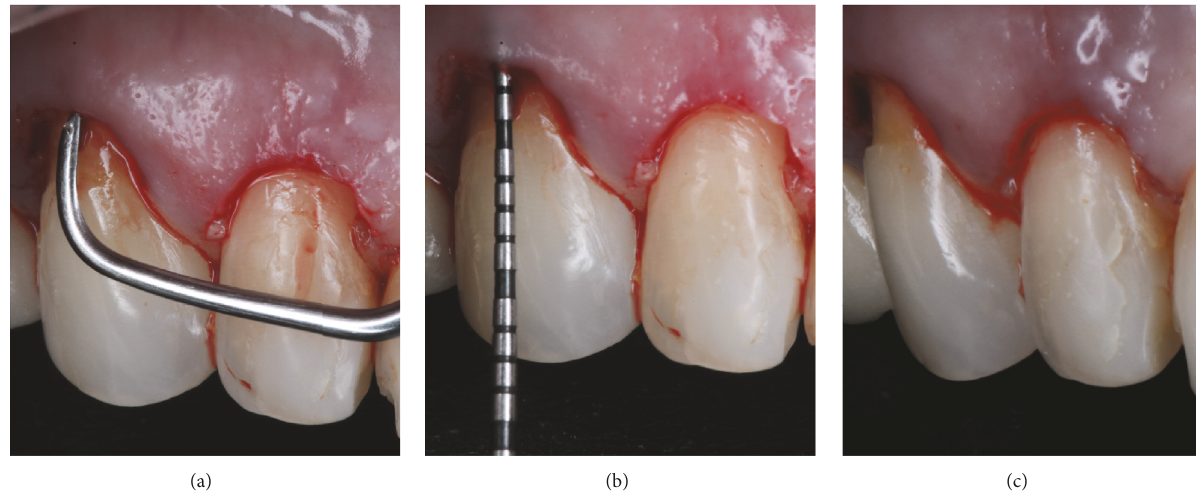
Figure 8: Ninety days after the first intervention a flapless crown lengthening surgery was performed to reposition the zenith in teeth 12 and 13. Bone removal was performed with periodontal Micro-Chisel and curette (a) to establish a 3 mm distance between the gingival margin and bone crest (b and c).